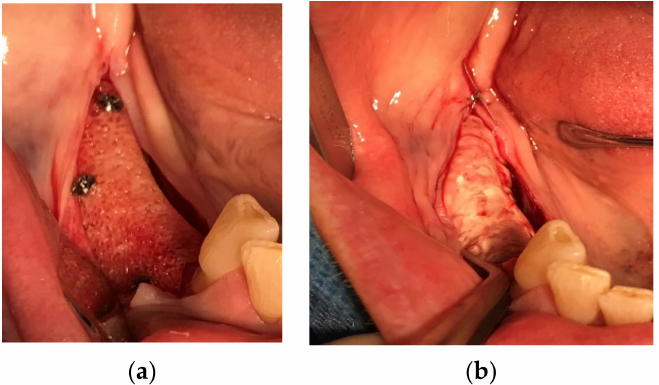
Figure 7. Bone block fixated with TruFix screws ( a ) and covered with Copioss ( b ).